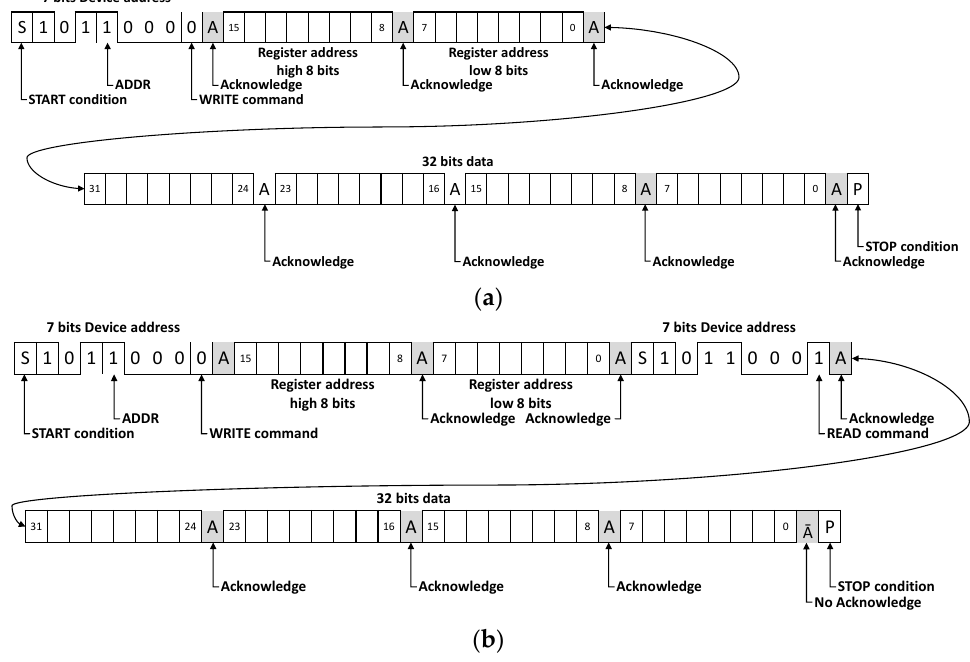
Figure 3. Timing diagram of I 2 C communication between MCU and DSP: ( a ) MCU and ( b ) MCU [9].